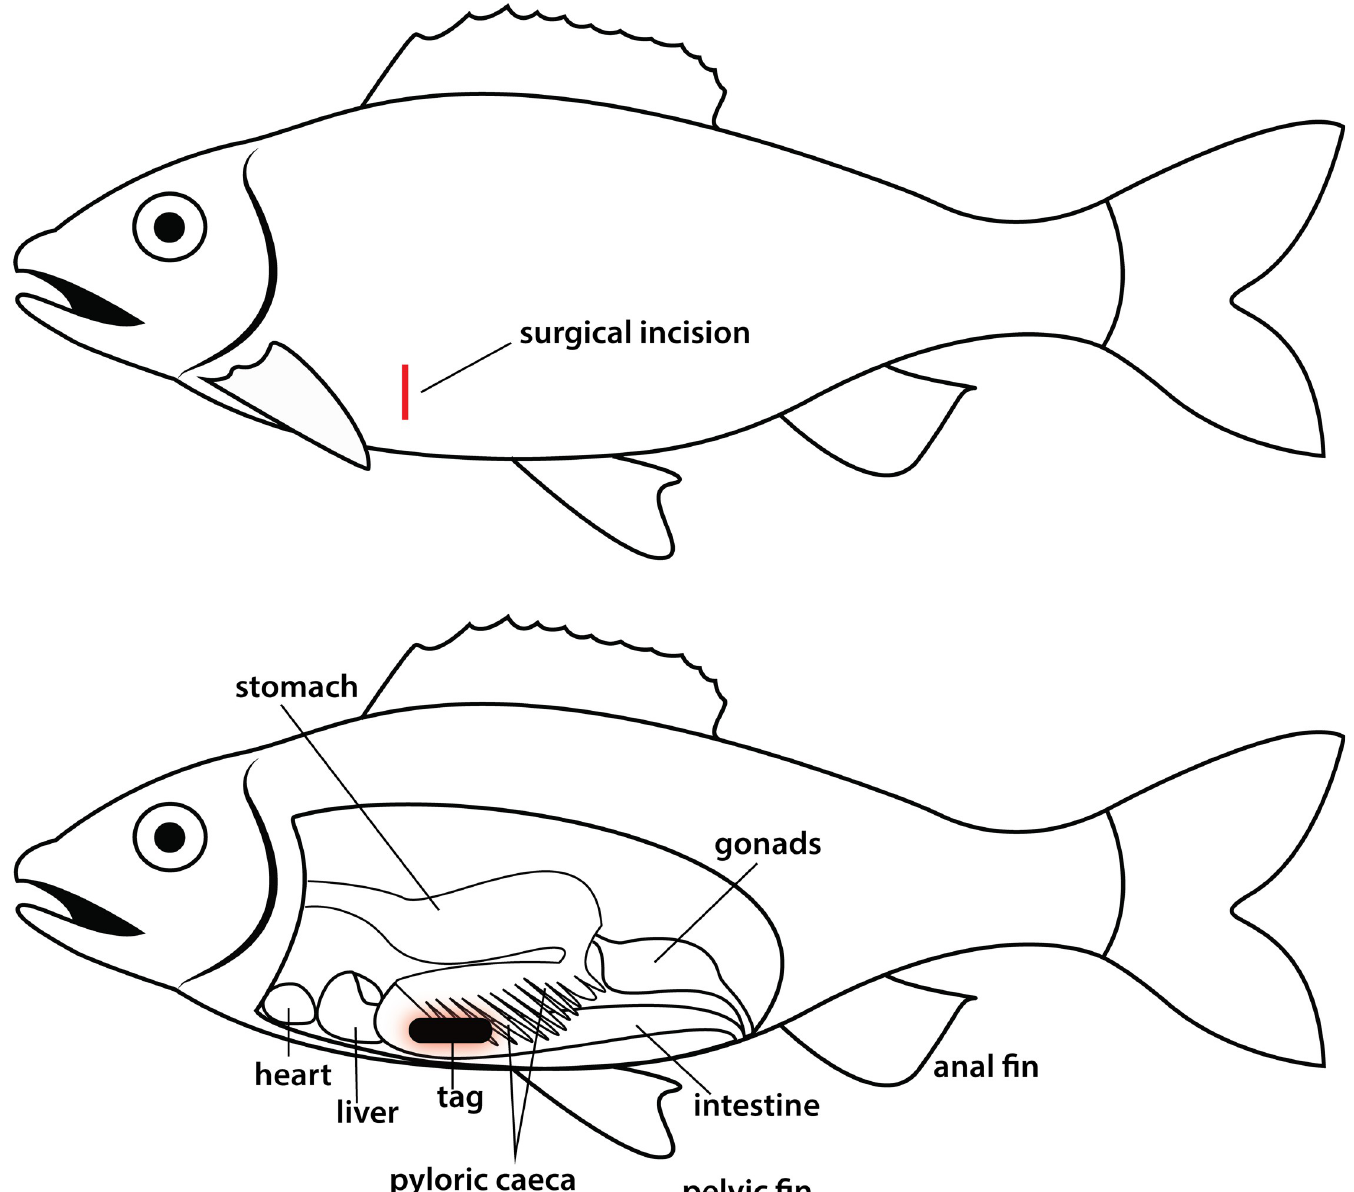
Fig 3. Position of the incision in red (top) and tag (bottom) following surgical implantation on the right lateral side of the fish, with internal anatomy shown.